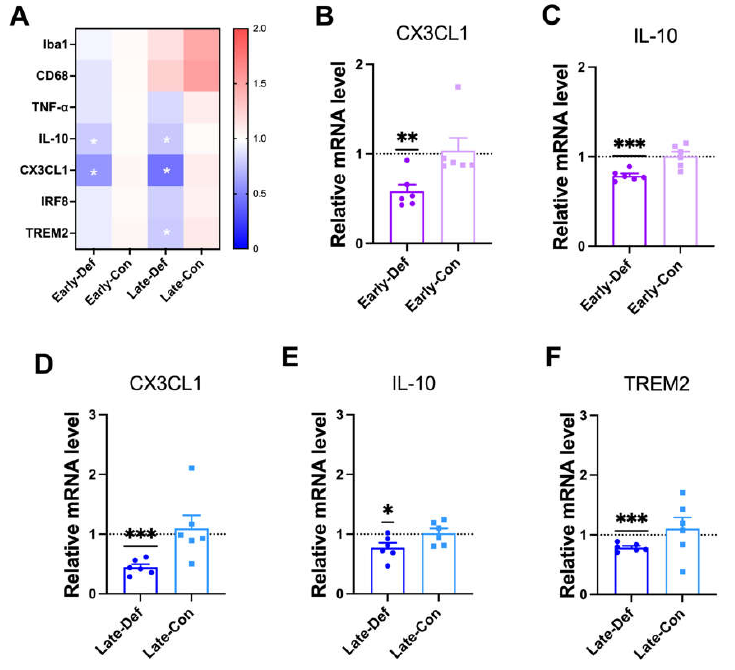
Figure 5. Vitamin D deficiency attenuated microglial activation and phagocytic responses. ( A ) A heatmap of qRT-PCR results for gene expression-related microglial function in Early-Def ( n = 6), Early-Con ( n = 6), Late-Def ( n = 6), and Late-Con ( n = 6) are shown. ( B , C ) The results from the qRT- PCR analysis of the mRNA expression of ( B ) CX3CL1 and ( C ) IL-10 in the Early- Def and Early-Con groups are shown. ( D – F ) The qRT-PCR results of the mRNA expression of ( D ) CX3CL1, ( E ) IL-10, and ( F ) TREM2 in the Late-Def and Late-Con groups are illustrated. Dots represent the data of individual mice in each group. The data are presented by the mean ± SEM of each group. * p < 0.05, ** p < 0.01, and *** p < 0.001 by the Student’s t -test.